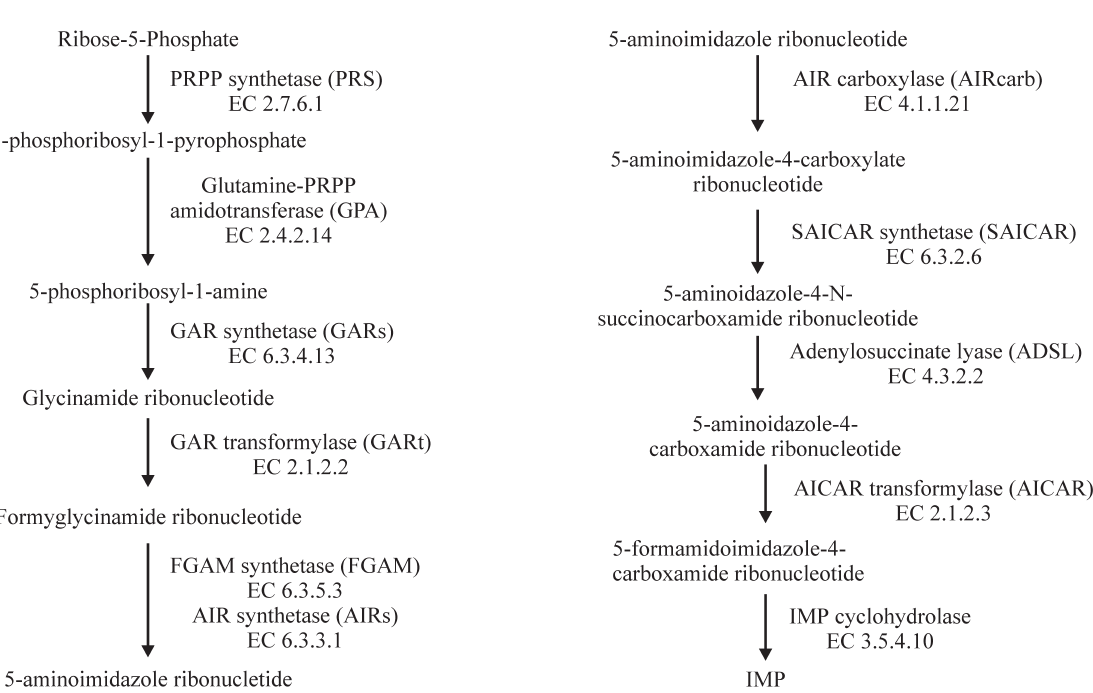
Figure1 -Thepurinesynthesispathwayshowingtheelevenenzymesparticipatinginthemetaboliccascadeandthepathwayintermediates.TheECnum- bers are also indicated below the enzyme name. Formylglycineamidine ribotide (FGAM) synthetase and aminoimidazole ribotide (AIR) synthetase par- ticipate in the same enzymatic step and are so indicated. Sugarcane aminoimidazole carboxamide ribotide (AICAR) transformylase and inosine monophosphate (IMP) cyclohydrolase have been identified as a single cluster representing a bifunctional enzyme.